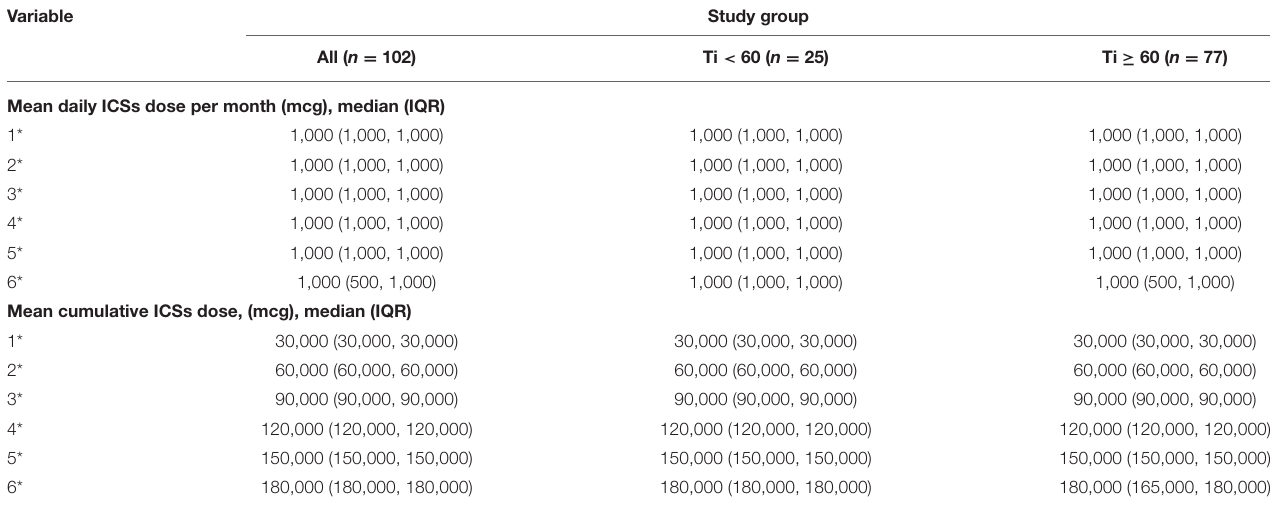
TABLE 5 | Description statistics of outcome variables.